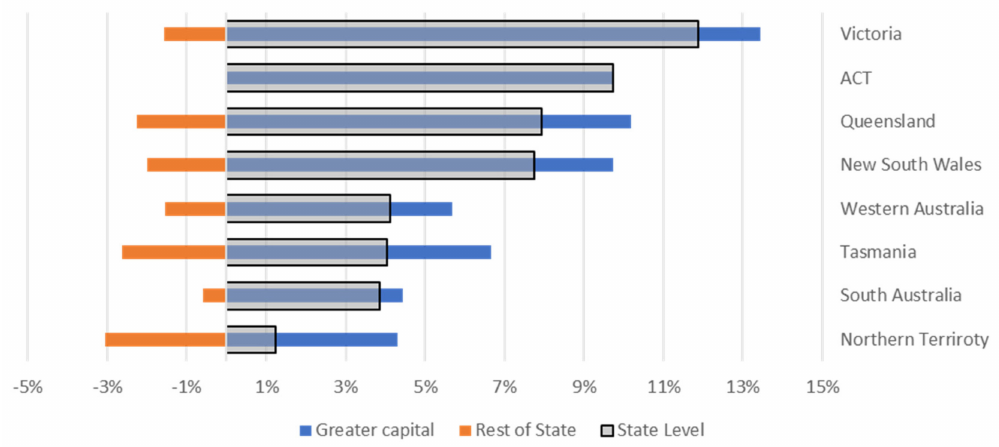
Figure 6. Population growth rate of states, greater capitals, and rest of state areas over the last